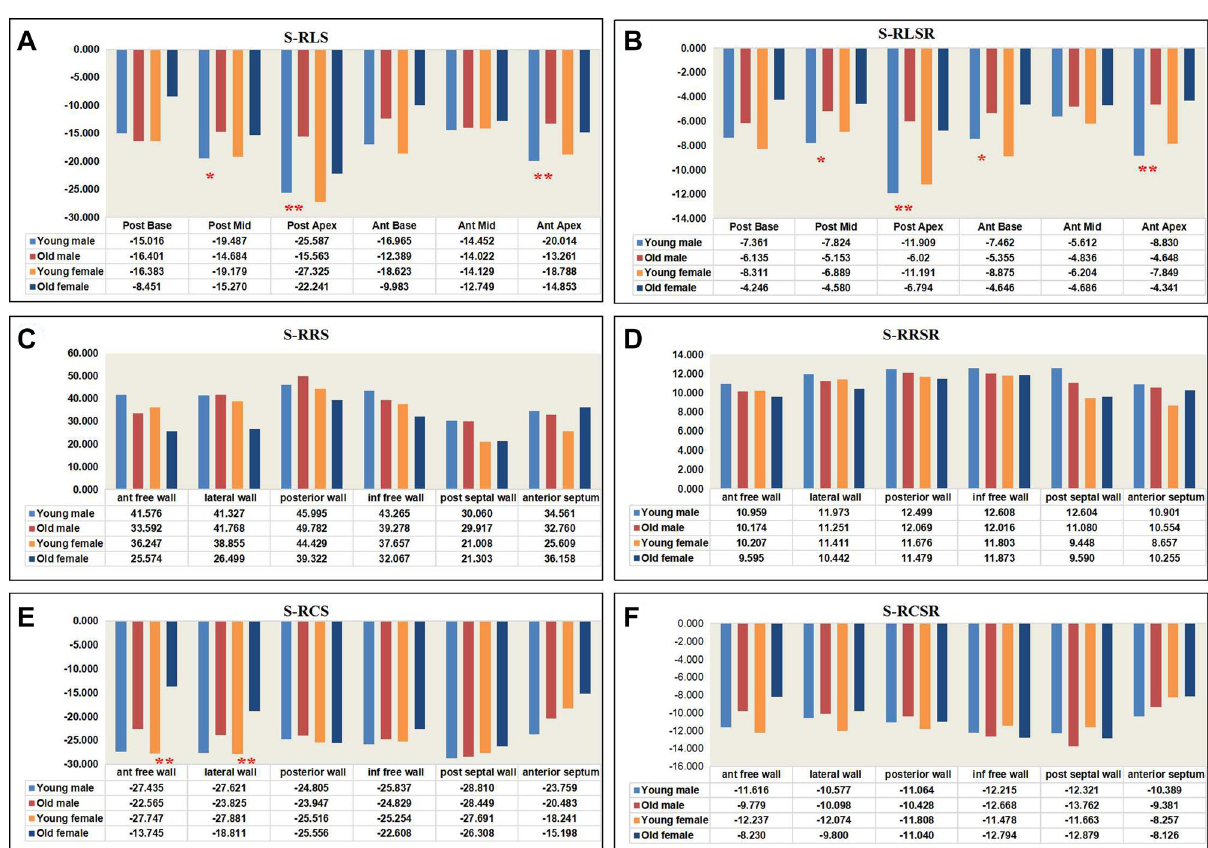
Figure 6. Cardiac systolic functional regional strain parameters. ( A ) systolic regional longitudinal strain ( B ) systolic regional longitudinal strain rate ( C ) systolic regional radial strain ( D ) systolic regional radial strain rate ( E ) systolic regional circumferential strain ( F ) systolic regional circumferential strain rate. * S-RLS systolic regional longitudinal strain; S-RLSR systolic regional longitudinal strain rate; S-RRS systolic regional radial strain; S-RRSR systolic regional radial strain rate; S-RCS systolic regional circumferential strain; S-RCSR systolic regional circumferential strain rate. Old males versus young males * P < 0.05, ** P < 0.01. Old females versus young females # P < 0.05, ## P < 0.01.